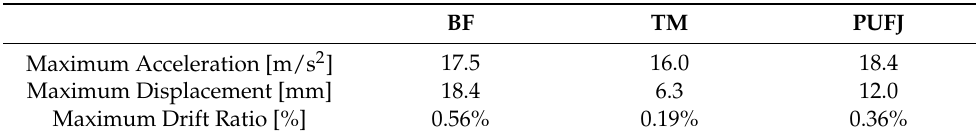
Table 3. Acceleration and displacement responses of the